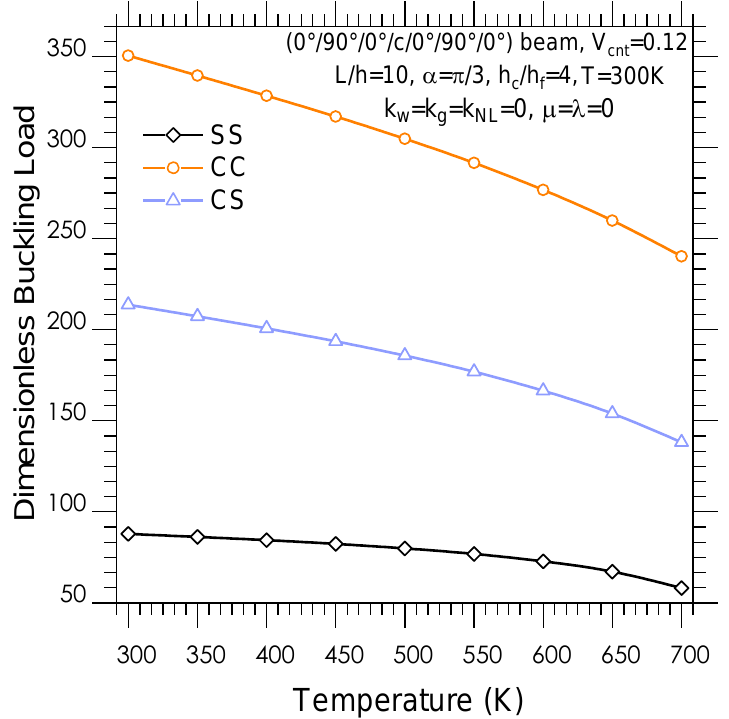
Figure 6. Dimensionless buckling load versus temperature.